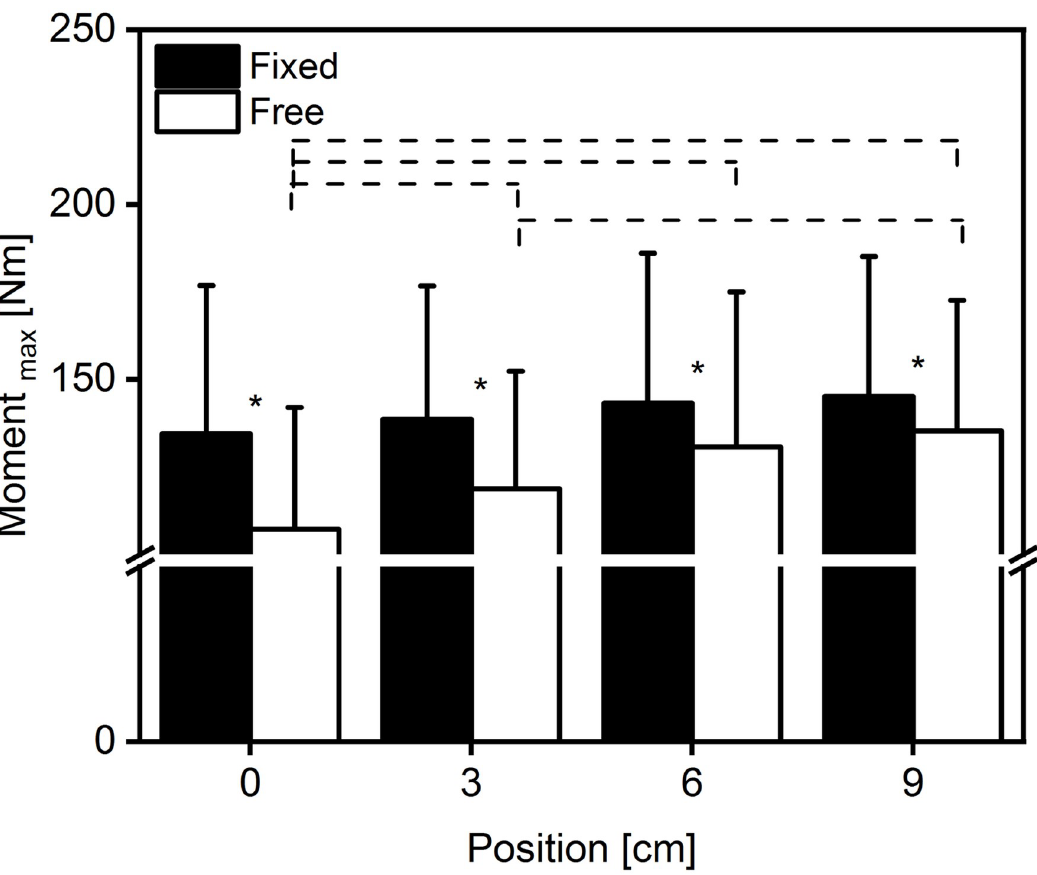
Fig 2. Average maximal plantarflexion moment at four positions and two conditions. Average (mean ± SD) maximum plantarflexion moment at four different positions (0–9 cm) and two different conditions (Fixed = filled bars, Free = empty bars). � : Indicates significant difference between conditions. Dashed line: Indicates significant difference between positions (n =